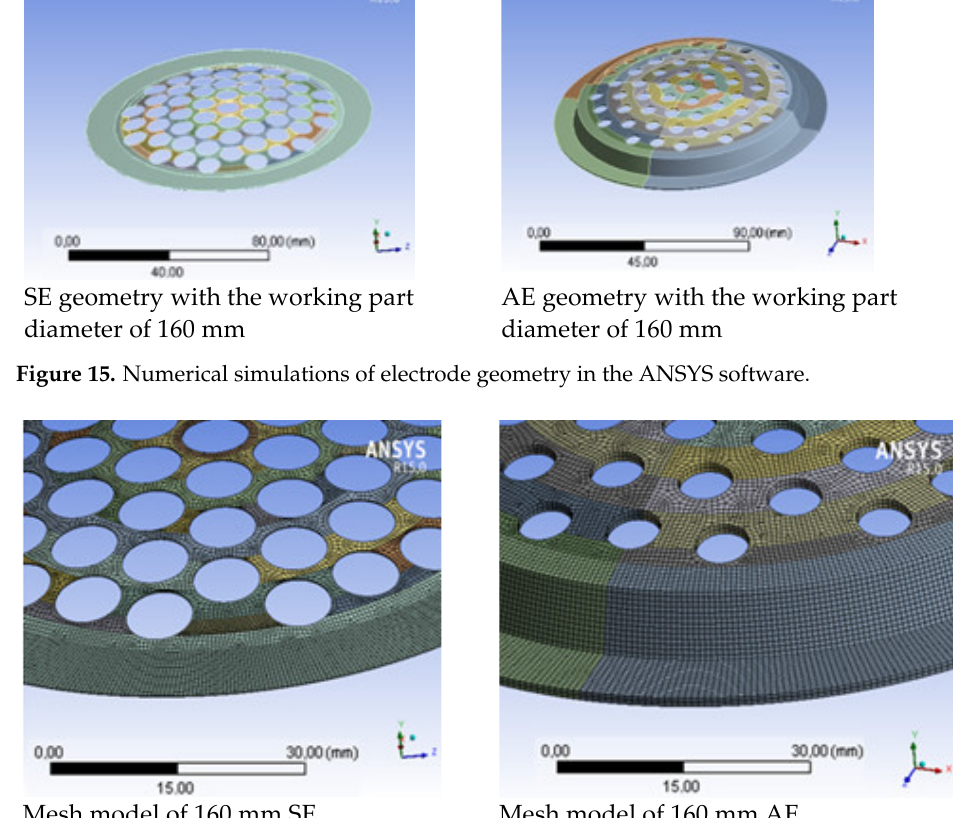
Figure 16. Element-by-element partition of electrodes in the ANSYS software—mesh model devel- opment.